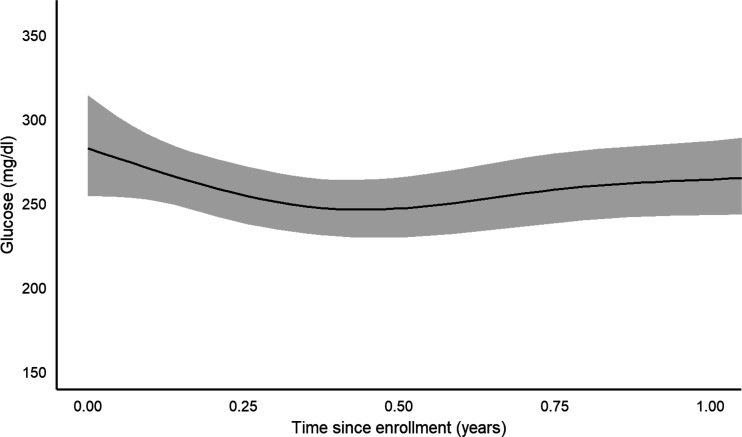
Estimated Change in Glucose Over Time After Enrollment in Rural Diabetes Care Program, Guatemala